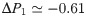
An example of long–range positive epistasis with ϵ = 0.77.Panel (A) describes the reference fold obtained for the initial sequence; Panel (B) describes the reference fold obtained for the double mutant. Dotted spheres indicate the positions of mutated amino acids. Individual mutations, R1 (orange) → G1 (green) and T12 (yellow) → I12 (light blue) are strongly deleterious, with ΔP1≃−0.61 and ΔP2≃−0.29 respectively (ΔP12≃−0.13). R1 is ordered (T12 is disordered) in the initial ensemble, and I12 is ordered (G1 is disordered) in the double mutant ensemble. The distance between mutated positions in panel (A) is R≃8 Angstroms. Folded ensembles for the initial and mutated sequences are shown in S4 Fig.